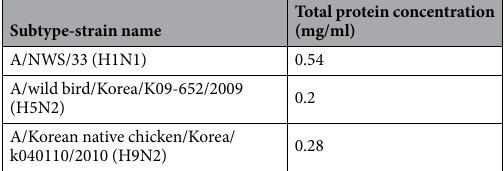
Table 1. The strain names with subtype and total protein concentration of each virus samples are